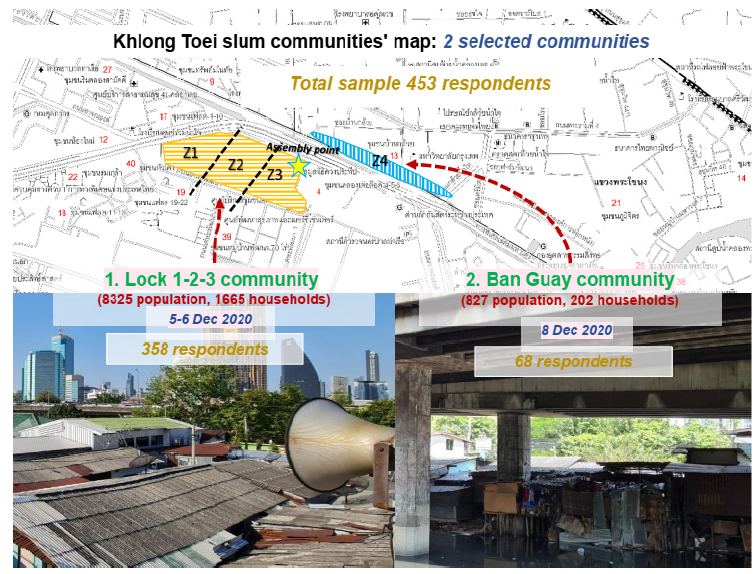
Figure 1. Lock 1-2-3 and Ban Guay, Khlong Toei slum communities, Bangkok, Thailand.